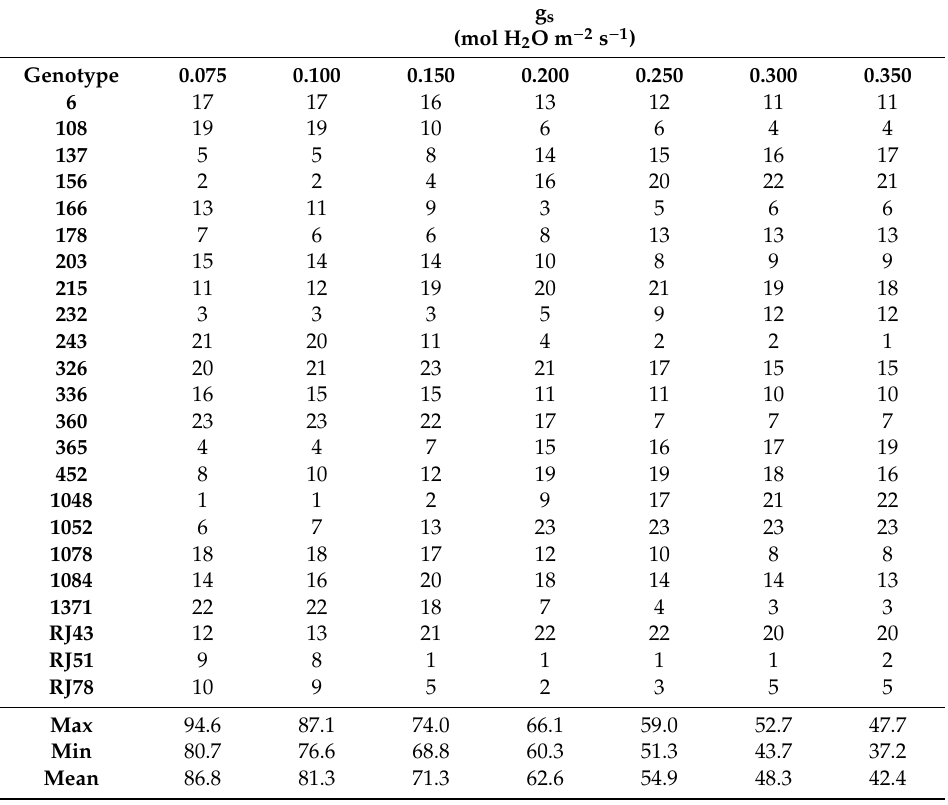
Table 3. The relative position of WUE i predicted for each genotype linear regression at different g s. The maximal, minimal, and the mean value of all genotypes were including in μ mol CO 2 mol − 1 H 2 O.